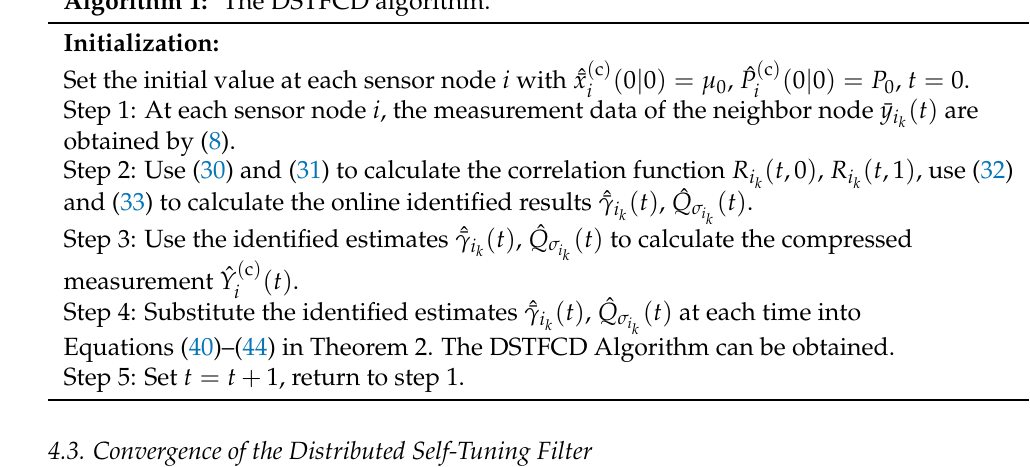
Algorithm 1: The DSTFCD